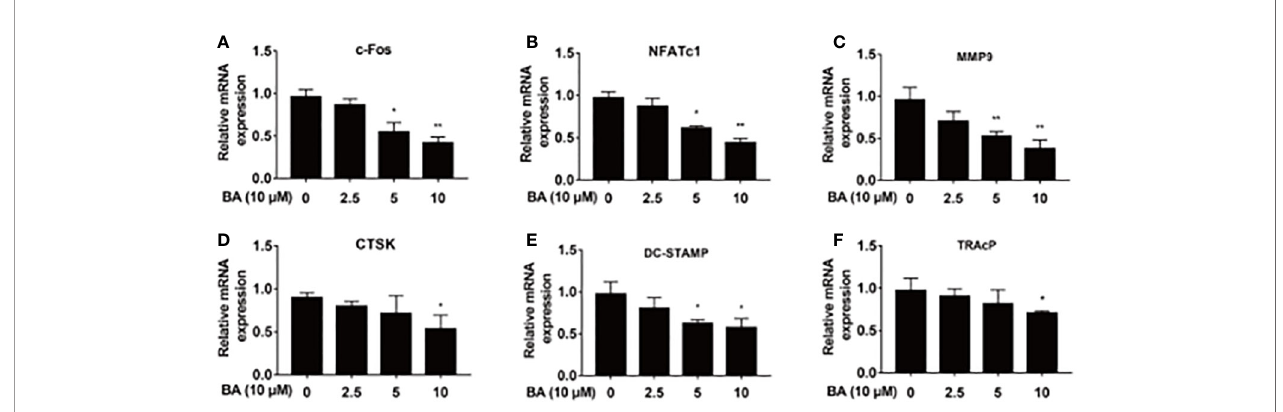
FIGURE 4 | BA downregulates the expression of osteoclast-speci fi c genes. (A – F) The qRT ‐ PCR assay detected mRNA amounts of osteoclastogenesis-associated marker genes, including c-Fos, NFATc1, MMP9, CTSK, DC-STAMP and TRAP. (n = 3/group). Data are mean ± SD. *p <0.05, **p <0.01 vs. RANKL-induced control group (no BA administration). BA, Betulinic acid; PCR, polymerase chain